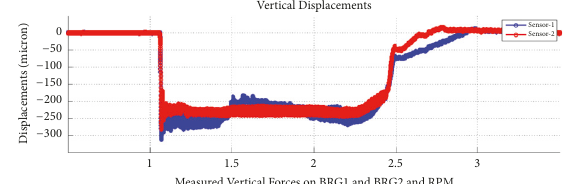
Figure 13: Experimental rotor vertical displacements during a landing test at DE (blue line) and NDE (red line) rotor nodes.